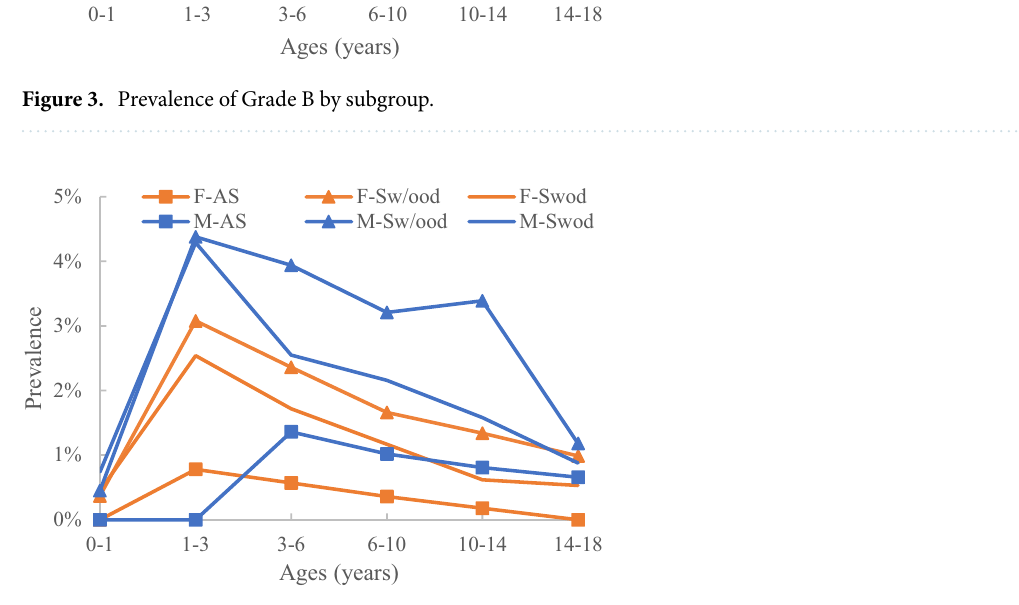
Figure 4. Prevalence of Grade A by